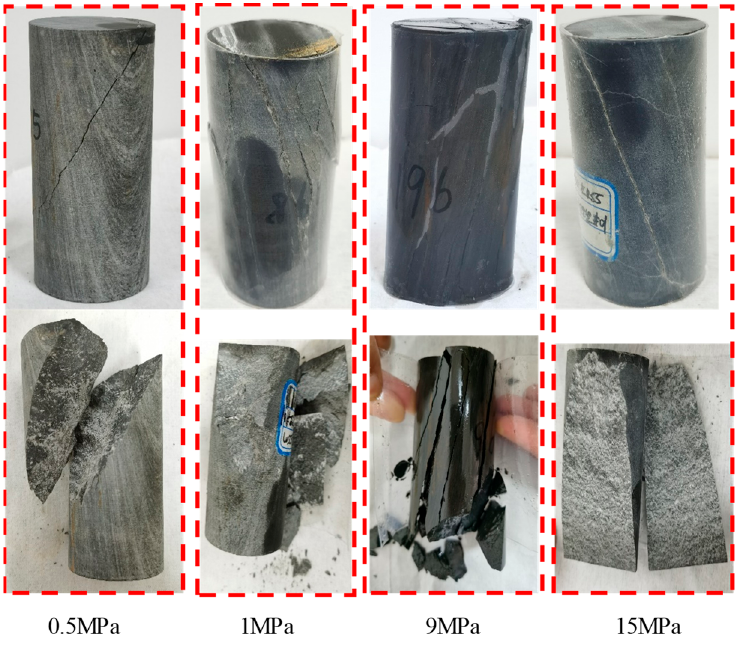
Figure 6. Failure modes of the dolomitic limestone samples under conventional compression tests at different confining pressures.